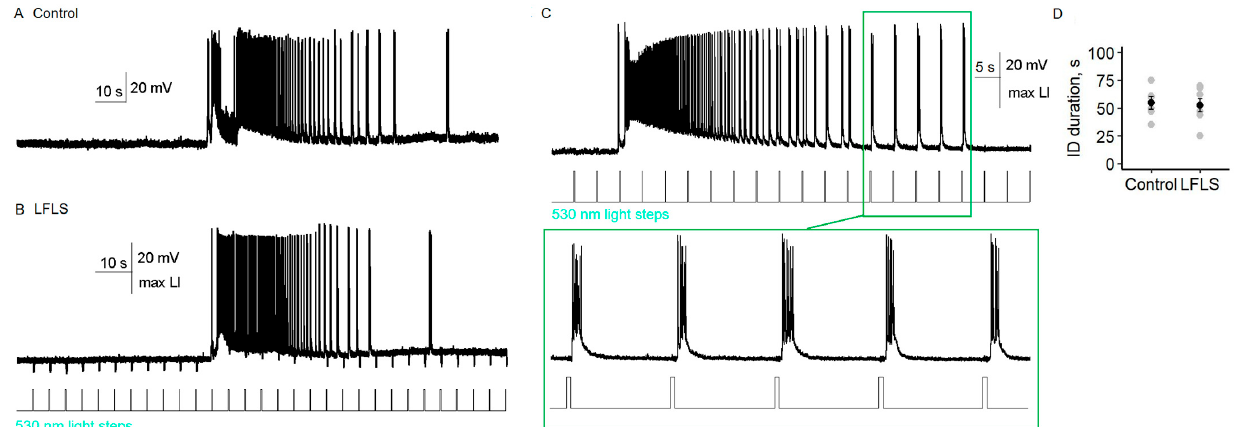
Figure 7. Low-frequency hyperpolarization of CaMKII neurons did not affect ictal activity in the entorhinal cortex. ( A , B ) Spiking activity of a representative CamKII neuron before (( A ) control) and during LFLS ( B ). ( C ) An example of ictal discharge during photostimulation when bursts in the clonic phase happened in response to the light turning off. ( D ) Statistical data for the duration of spiking activity during ictal discharge.